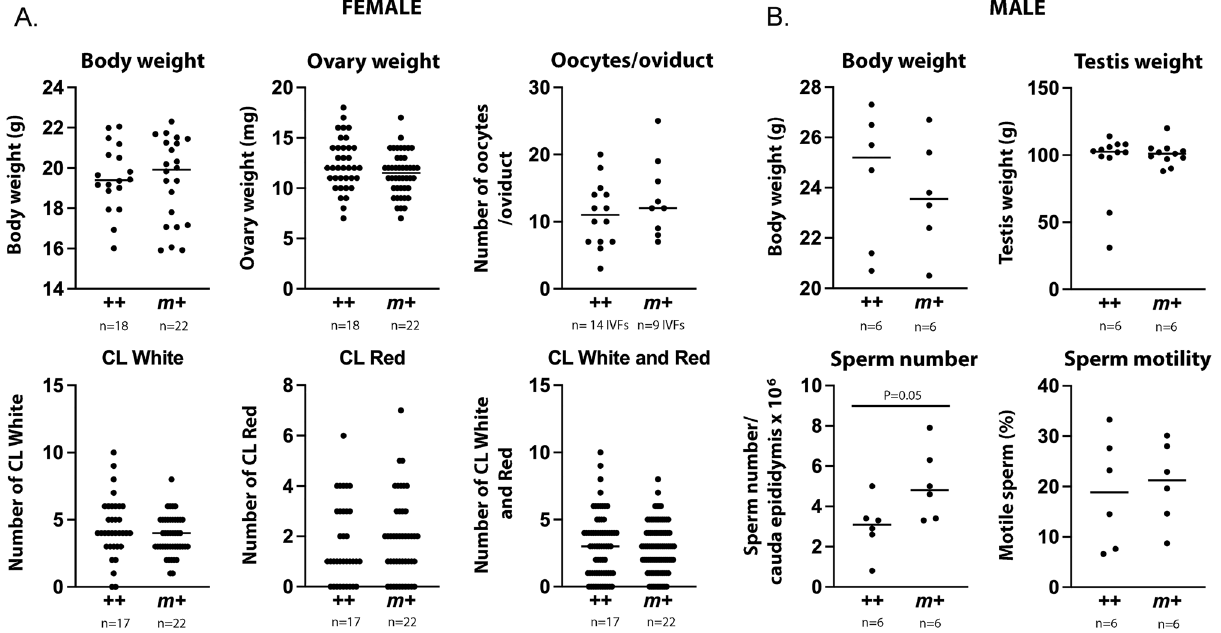
Figure 3. Reproductive features of A1cf mice. Female ( A ) and male ( B ) A1cf m + and ++ mice were examined in regard to their reproductive features. The n shown under each graph represents a number of mice, unless stated otherwise. The number of oocytes per oviduct was assessed during IVF so each value was derived by dividing the total number of oocytes by the number of oviducts from which they were released in each IVF. The females used for IVF were subjected to hormonal stimulation. All mice were 8–10 weeks old. CL, corpora lutea; CL White, old CL that regressed to a fibrous scar; CL Red, fresh CL that was still hemorrhagic. Statistical analysis ( t -test) revealed no significant differences between A1cf m + and ++ mice for any measured parameter except sperm